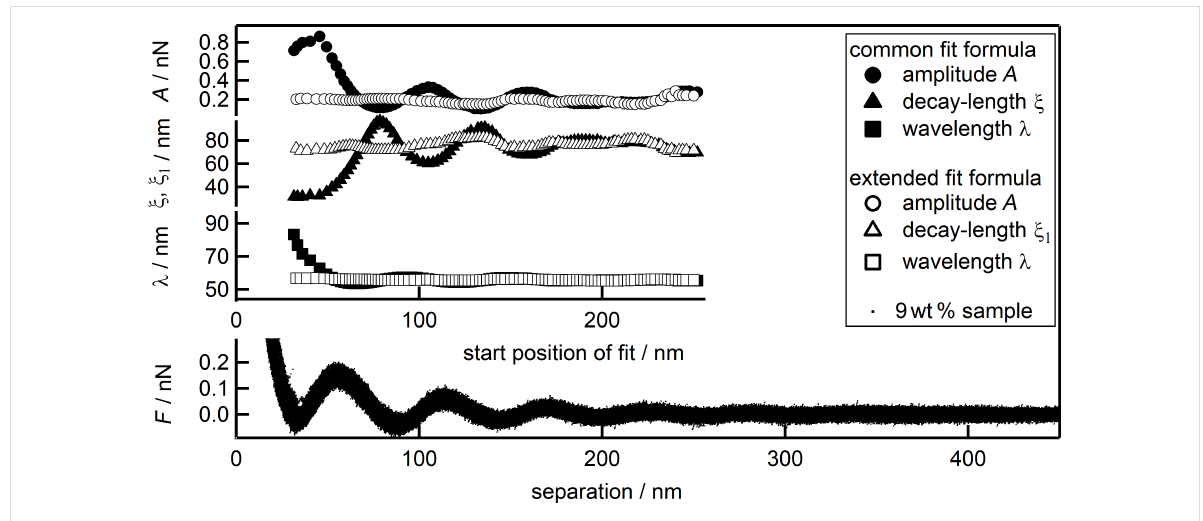
Figure 7: Combined force data of the 9 wt % suspension (black dots) together with the fit parameters over the separation or the starting point of the individual fit, respectively: A (circles), ξ , ξ 1 (triangles) and λ (squares). Open symbols represent parameters fitted with the new equation and the best combination of B and ξ 2 being kept constant, while full symbols represent the data from Figure 3 for ease of